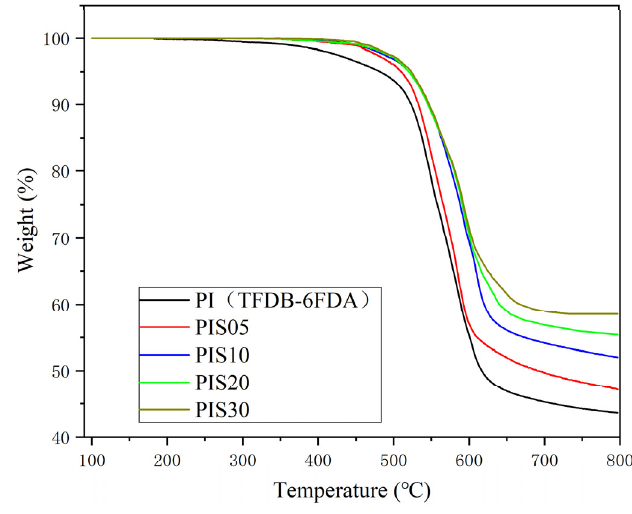
Figure 4. The TGA curves of the TFDB-6FDA system PI film, PIS05 and